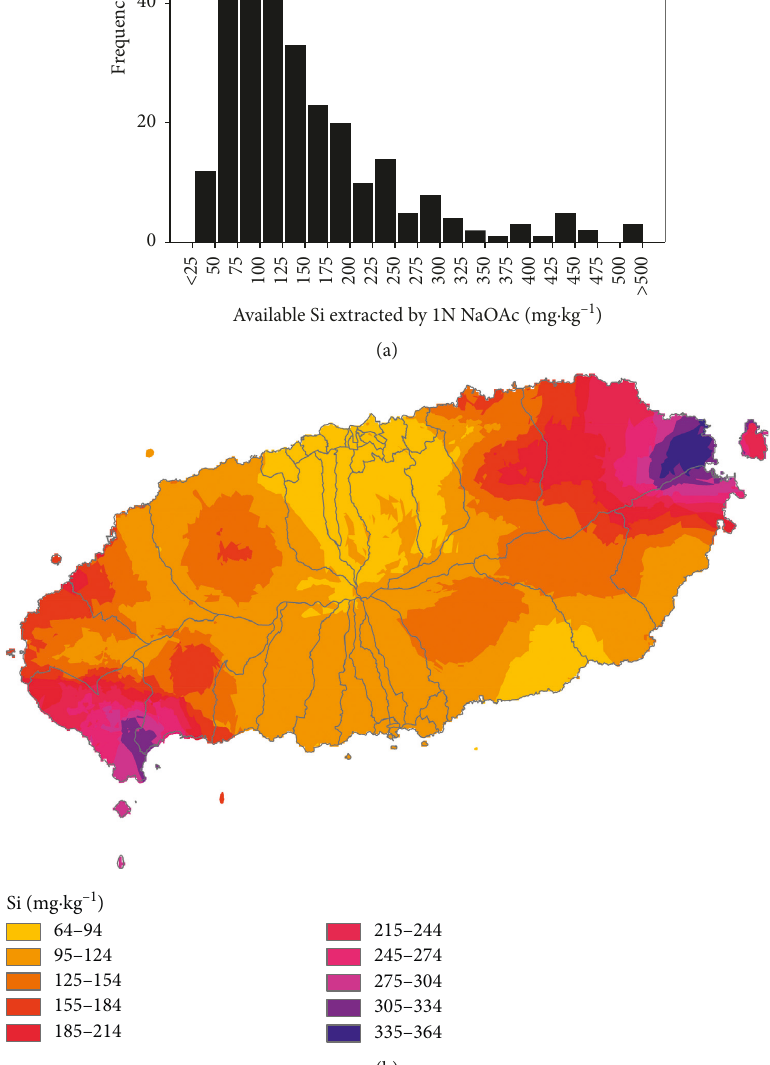
Figure 2: Frequency (a) and regional distribution (b) of available Si in topsoils on Jeju Island extracted using 1N sodium acetate buffer (NaOAc)